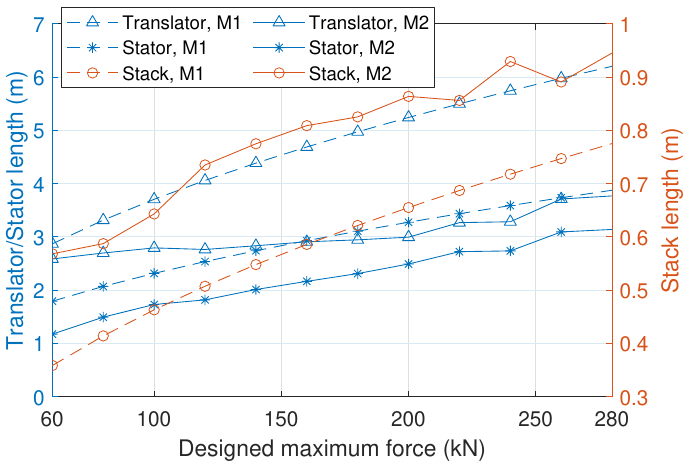
Figure 5. Scaled translator, stator and stack lengths for different designed maximum generator forces. “M1” and “M2” embody method 1 and method 2 for generator